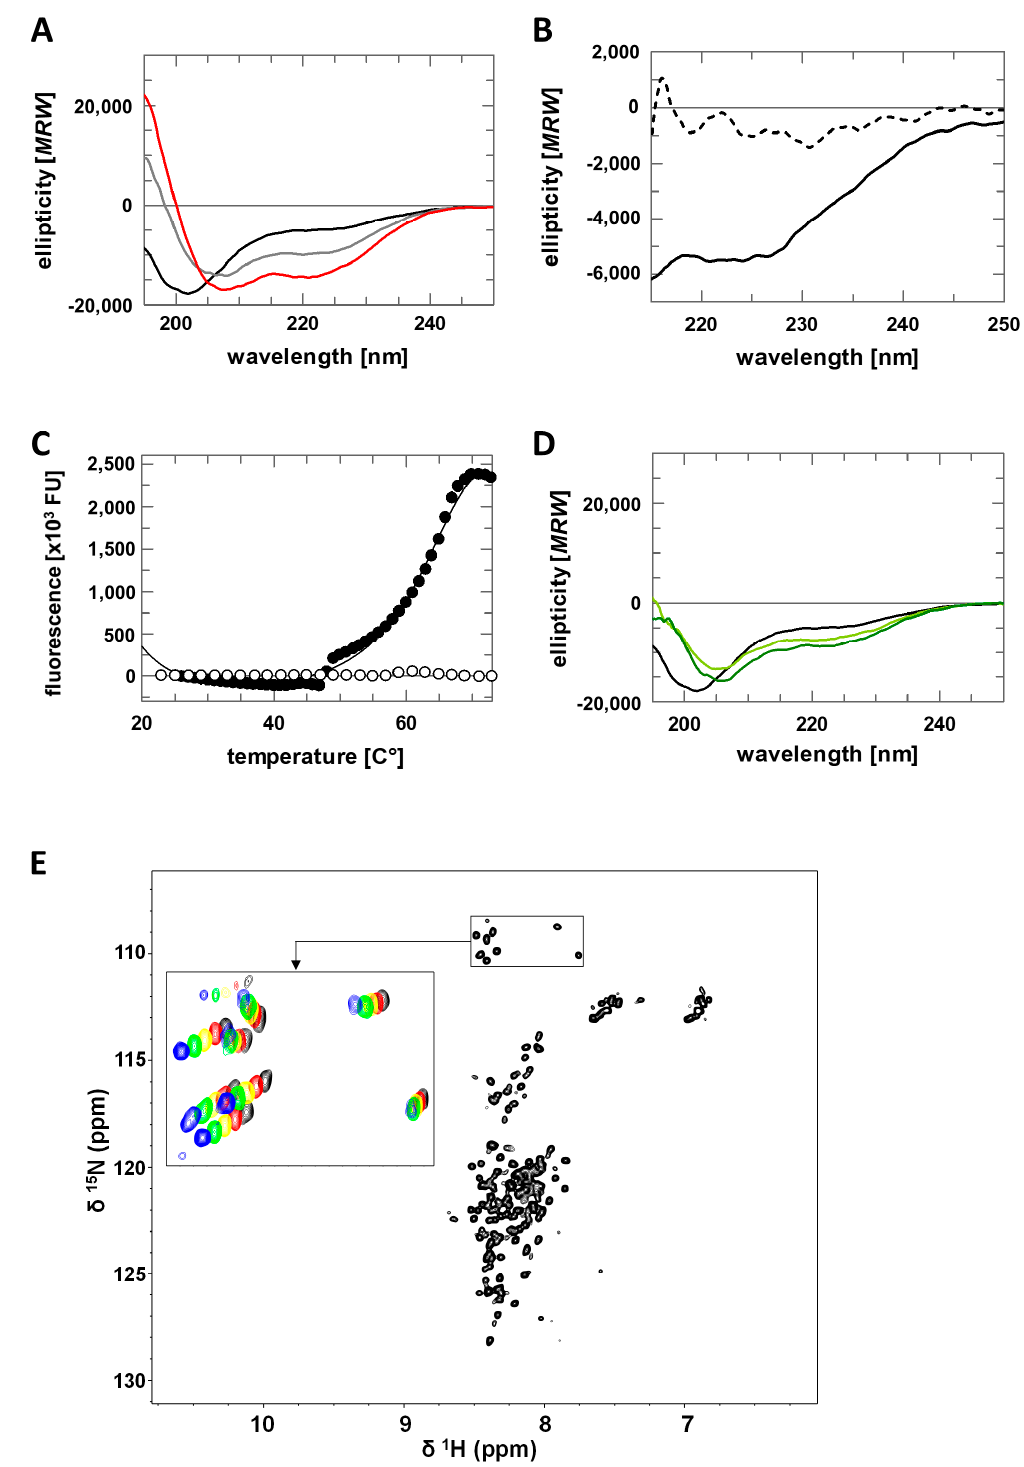
Figure 2. Structural characterization of AROS. ( A ) CD spectra of AROS in absence and presence of TFE (0% black, 10% grey, 20% red). ( B ) CD spectra of AROS in absence (solid line) and presence of 6 M urea (dashed line). ( C ) Thermal denaturation of AROS in absence (white) and presence of 50% TFE (black). ( D ) CD spectra of AROS in absence and presence of glycerol (0% black, 40% light green, 50% dark green). ( E ) [ 1 H, 15 N]-HSQC spectra of AROS with an enlarged view of glycine signals recorded at different temperatures (25 °C black, 20 °C red, 15 °C yellow, 10 °C green, 5 °C blue).